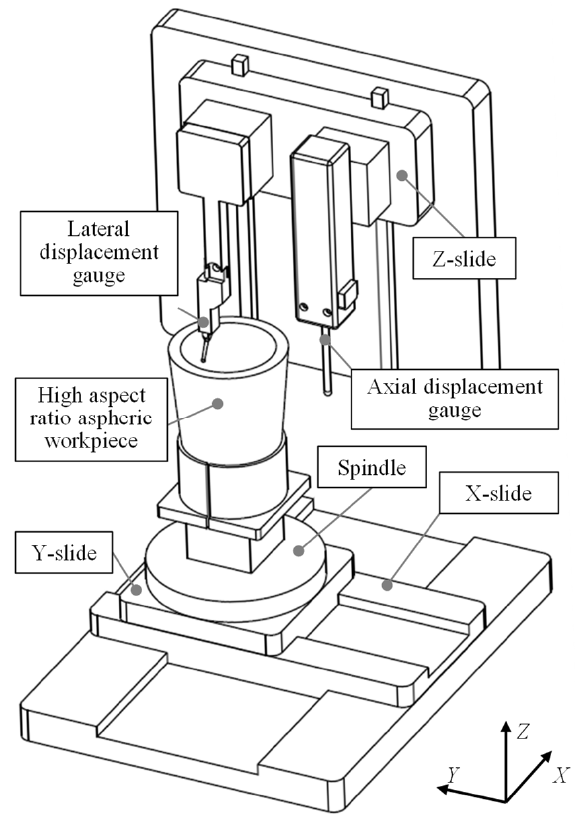
Figure 1. Schematic of the constructed two-probe measurement system.